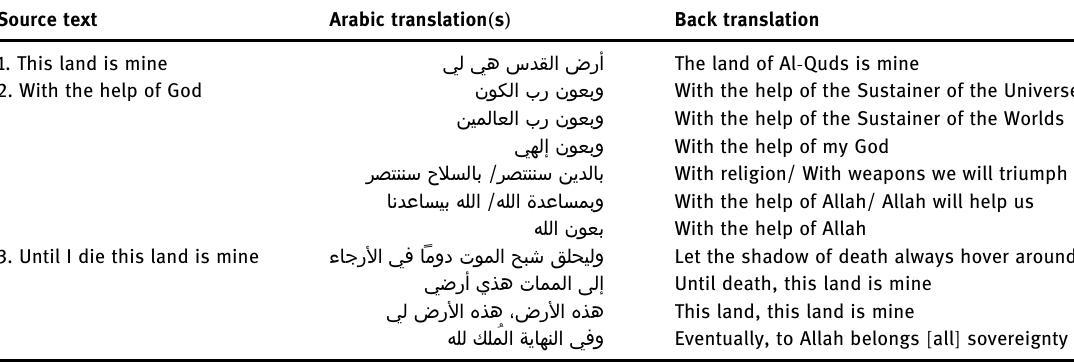
Table 1: Examples of religio - cultural manipulations Source